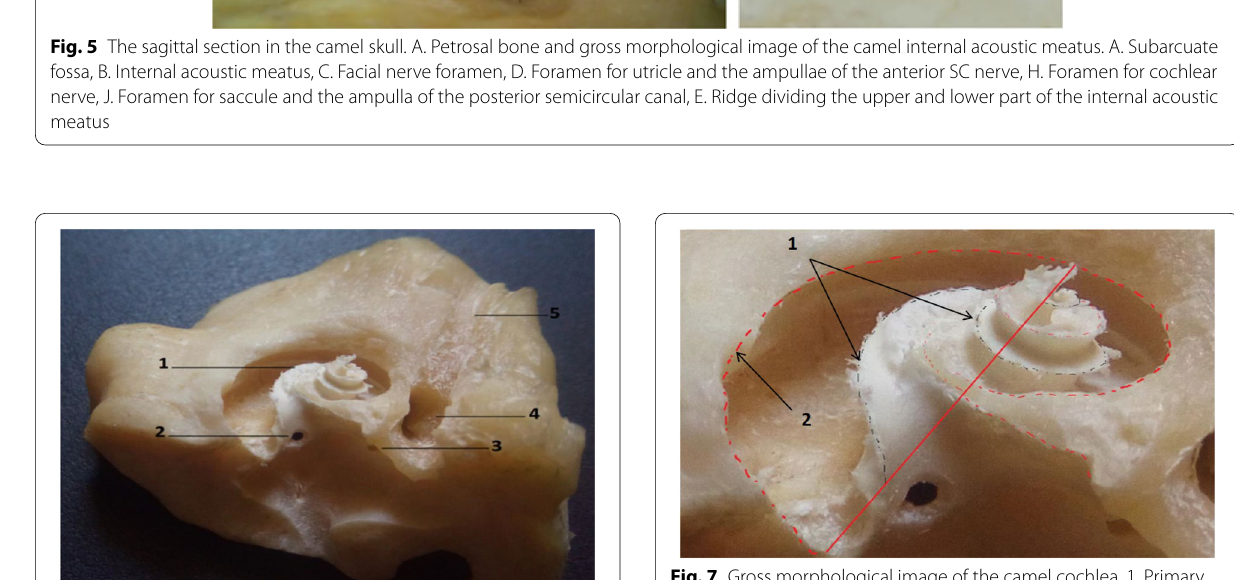
(Figs. 2B/B; 5/H) and the other foramen, which was sit- uated caudal to the ampulla of the posterior semicircu- lar duct nerve (Fig. 5/J). A canal for the greater petrosal nerve was detected (Fig. 6/5).